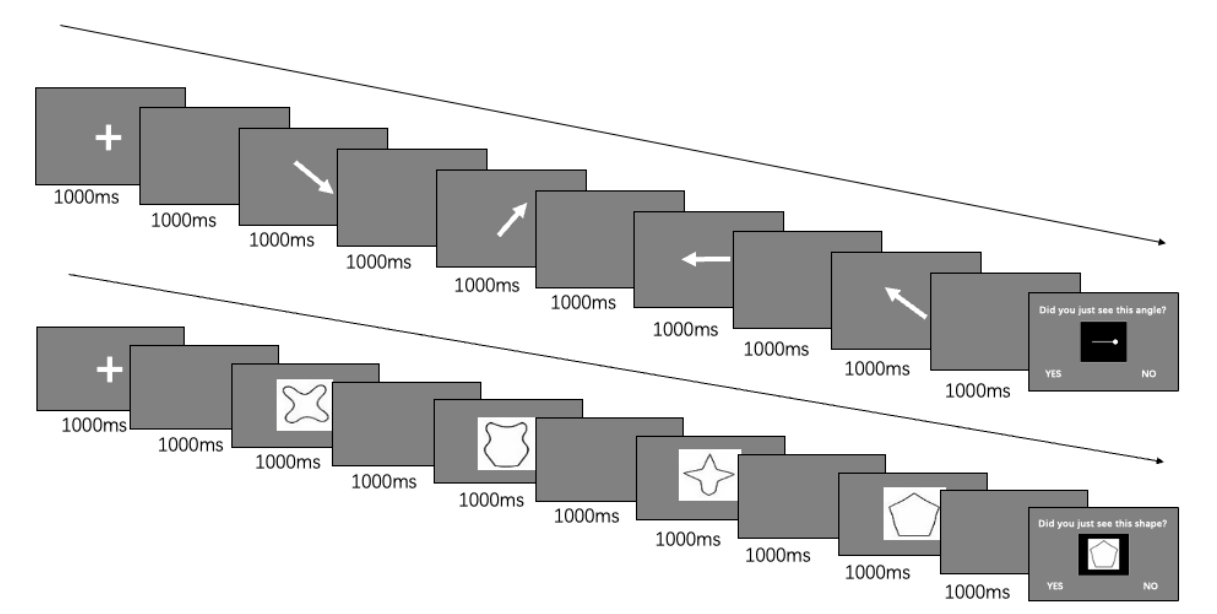
Figure 1. Detailed illustration of an orientation and a shape trial. Note . The upper row was an orientation test trial; the lower one was a shape test trial.